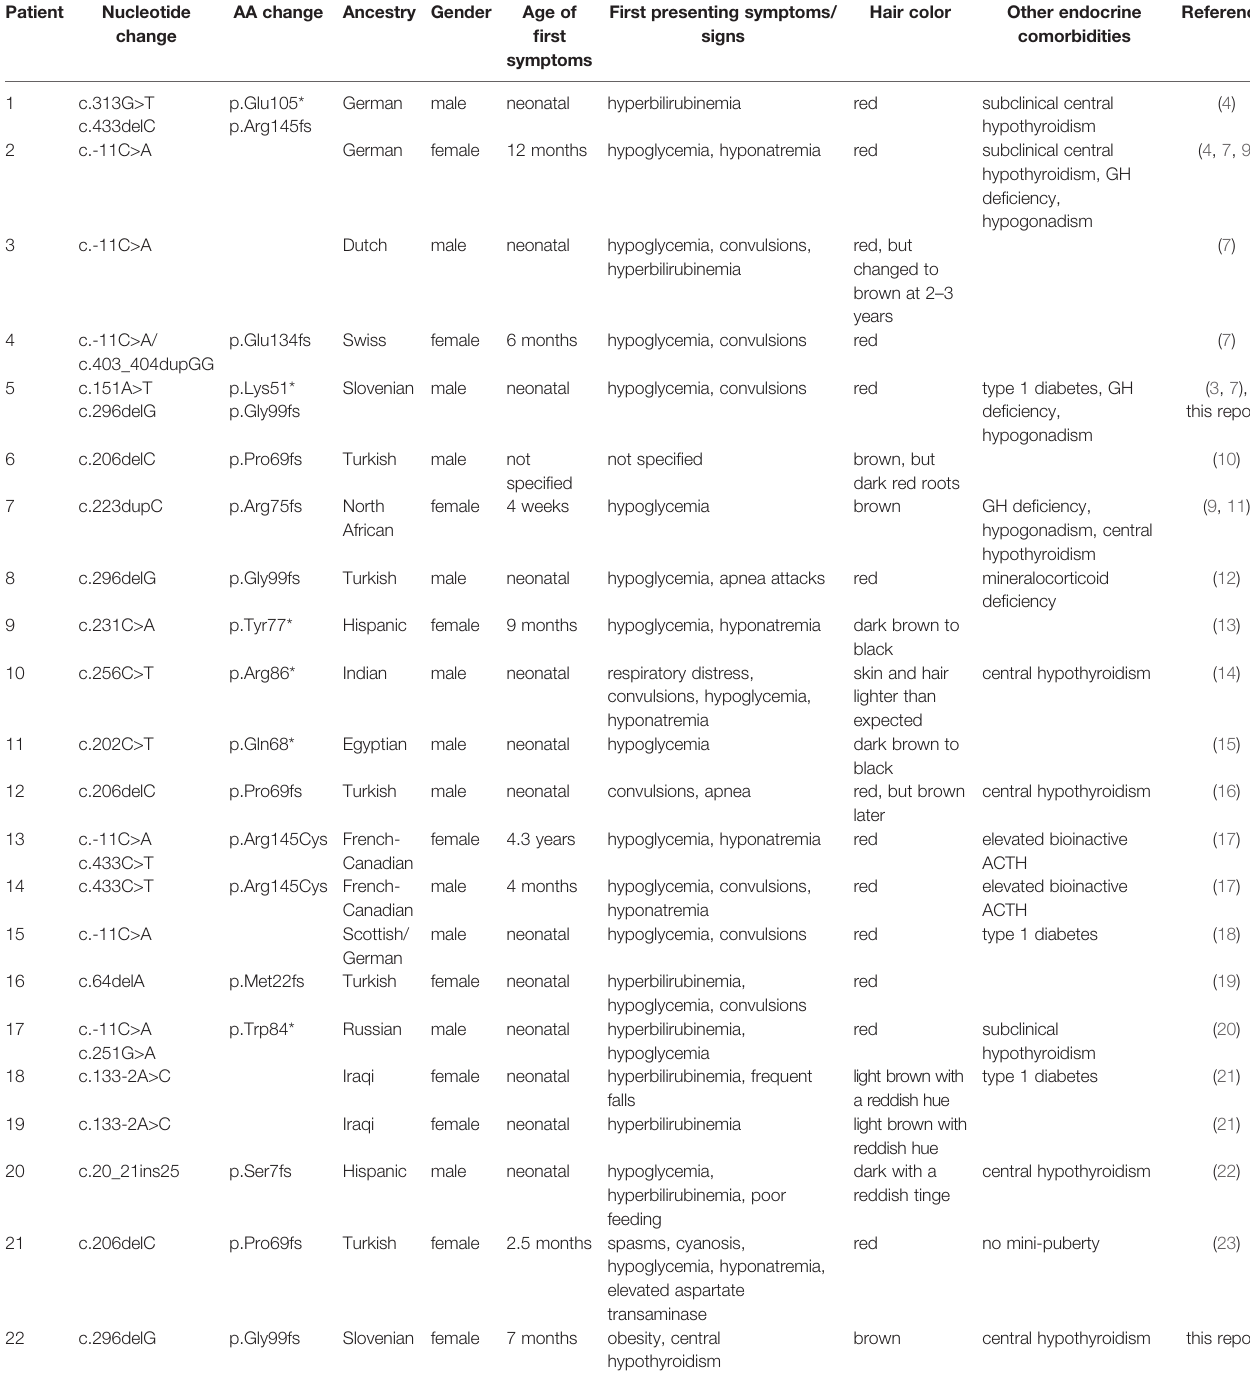
TABLE 1 | A list of reported cases of POMC de fi ciency so far.